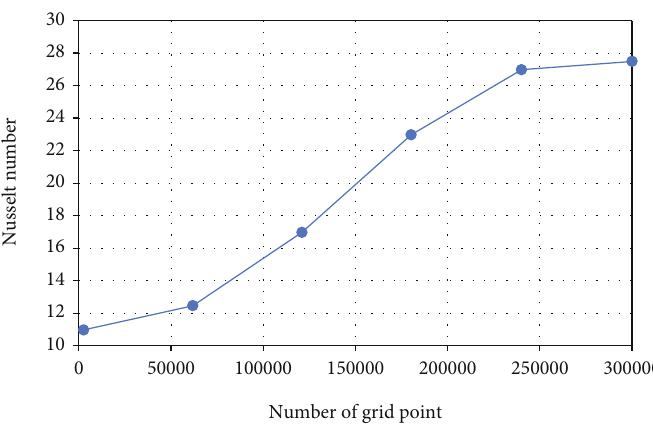
Figure 2: Changes in the Nusselt number with di ff erent numbers of networks.